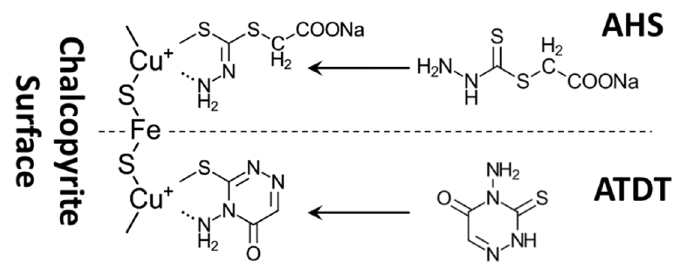
Figure 10. Proposed adsorption models of AHS and ATDT on chalcopyrite surface.